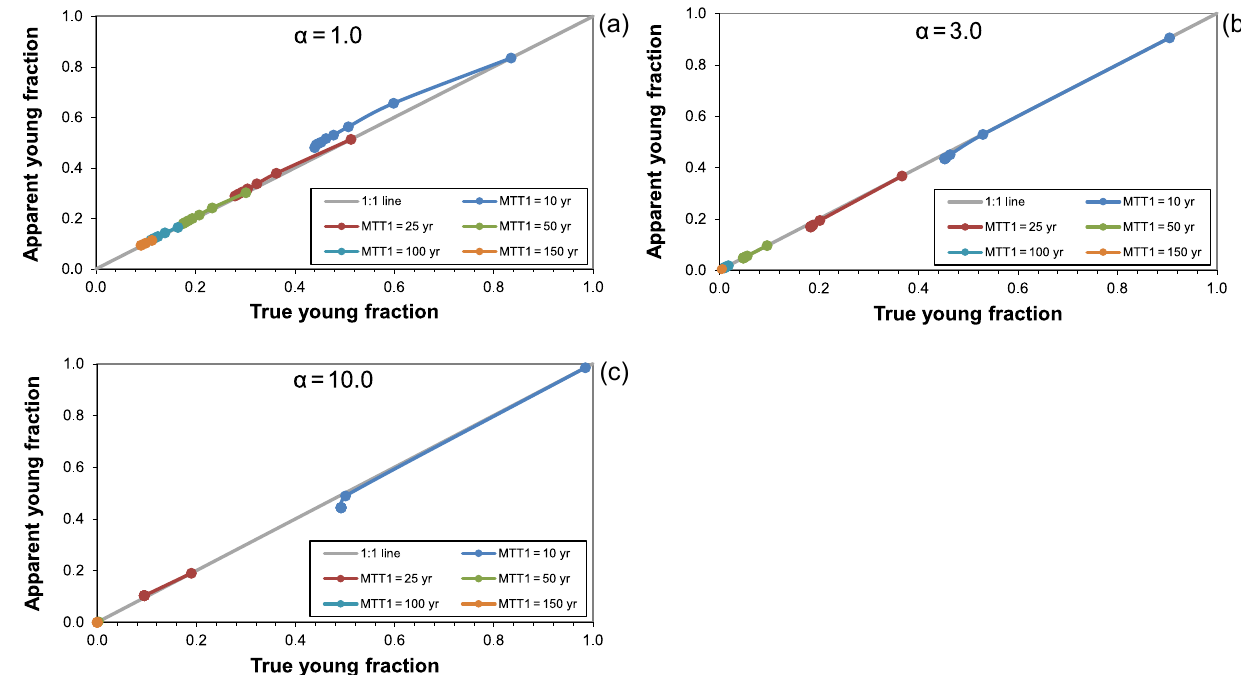
Figure 8. True versus apparent tritium young water fractions for GMs with different values of α using the Kaitoke input function. Curves show changes as component 2 (MTT2) becomes older in 50-year steps and therefore the mixtures become older in 25-year steps (shown by dots).